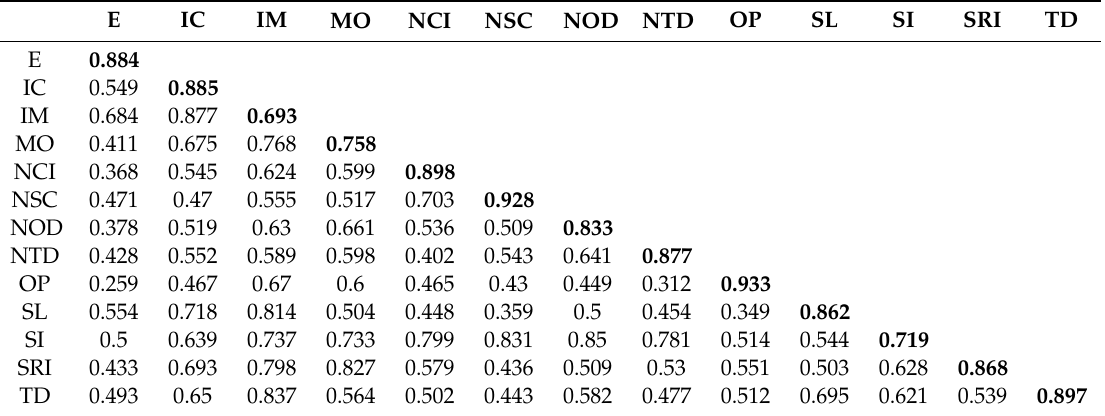
Table 4. Reflective first-order constructs reliability and discriminant